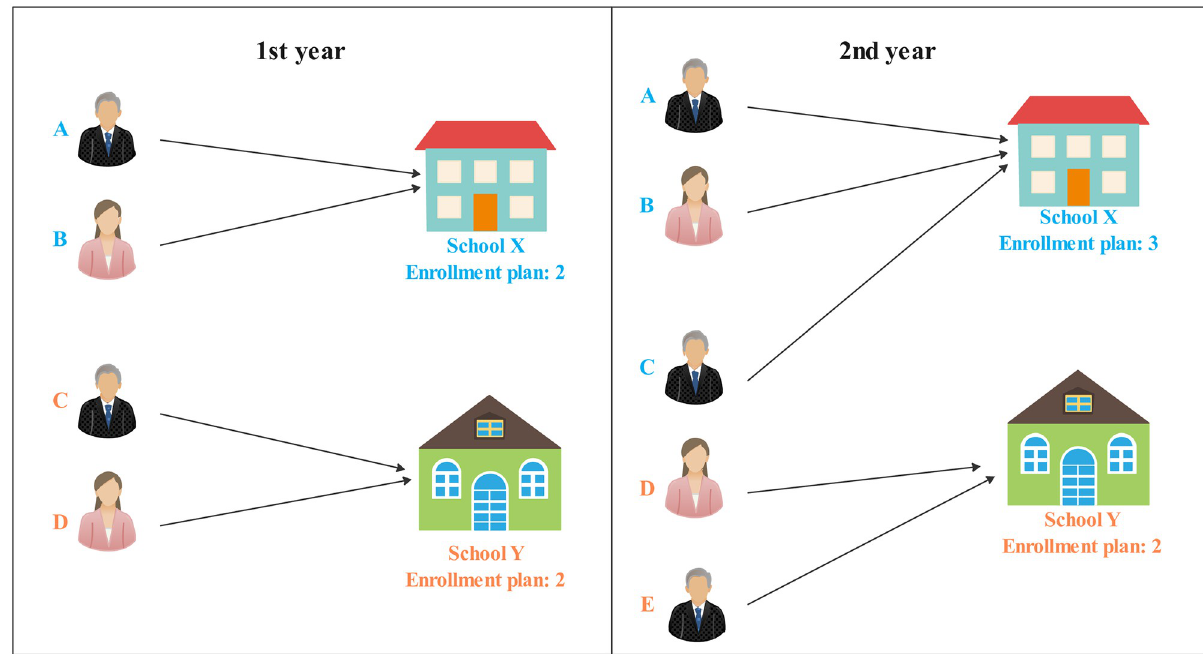
Fig 1. The schematic description of the competitive relationship between college X and Y. The changing number of enrollment plan of college X from the 1st year to the 2nd year results in the decreasing admission score of college Y in the 2nd year.